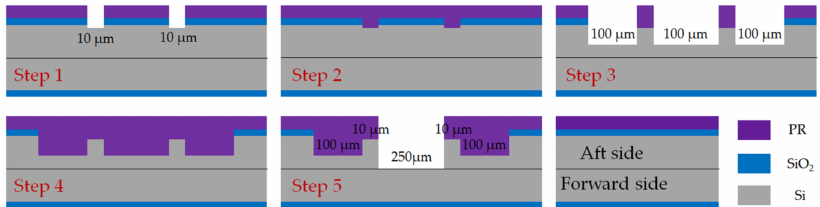
Figure 8. Process flow of traditional method for DRIE multi-depth structures on aft side of the second layer in